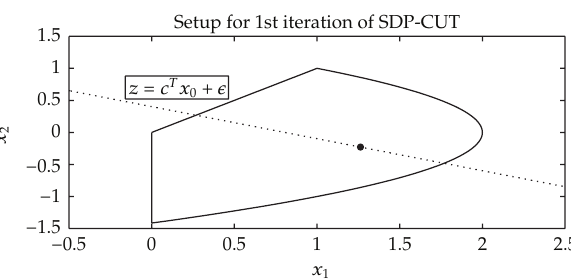
Figure 2: The first cutting constraint and an initial point x ∗